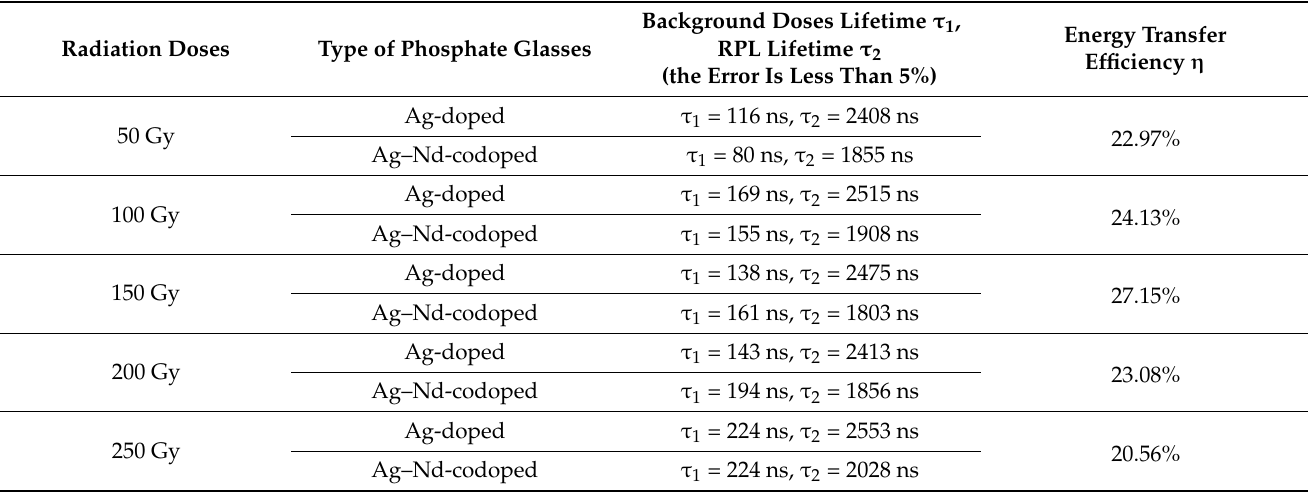
Figure 6. The RPL lifetime of Ag defect centers at 650 nm in Ag-doped and Ag–Nd-codoped phosphate glasses at different radiation doses (310 nm excitation). Table 2. Background doses lifetime τ 1 and RPL lifetime τ 2 of Ag coped and Ag–Nd-codoped phosphate glasses; energy transfer efficiency η from Ag defect centers to Nd 3+ ions in Ag–Nd- codoped glasses at different radiation doses (310 nm